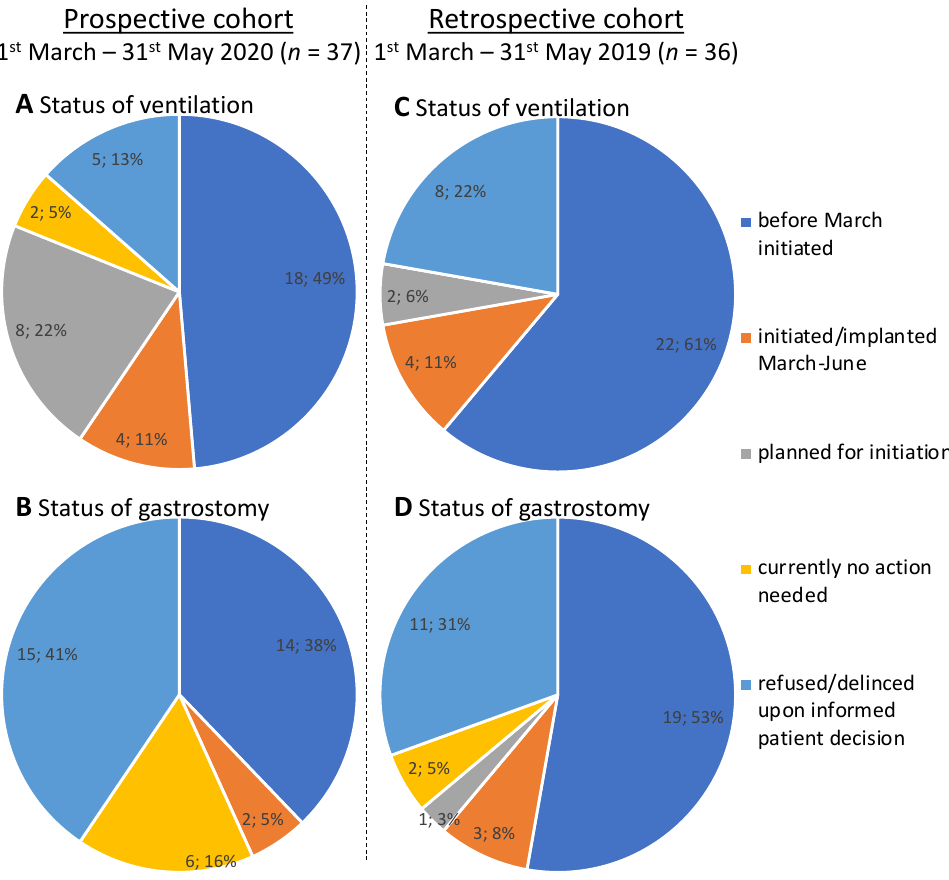
Figure 4. Results of the active follow-up for the prospective cohort from March until June 2020, concerning ( A ) the status of assisted ventilation or ( B ) the status of gastrostomy. For comparison purposes, the same situation is illustrated for the retrospective cohort, regarding the status of ( C ) ventilation and ( D ) gastrostomy.